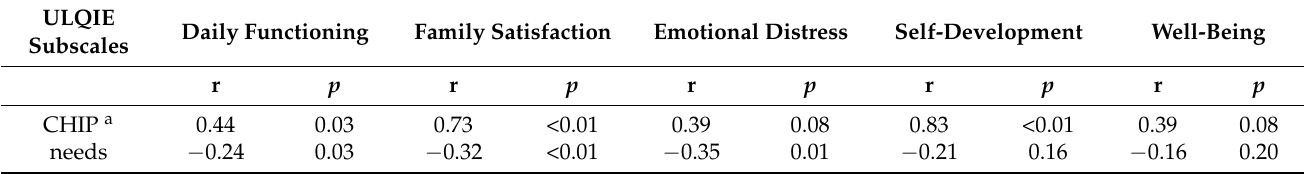
Table 7. Influencing Factors on parental Quality of Life (ULQIE